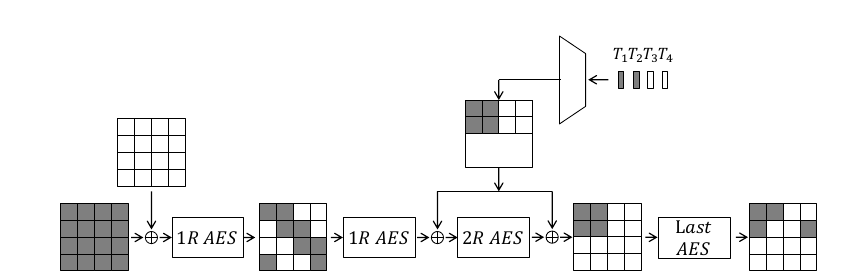
Figure 8: TweAES : 5-round Truncated Differential Attack using Tweak Difference (type